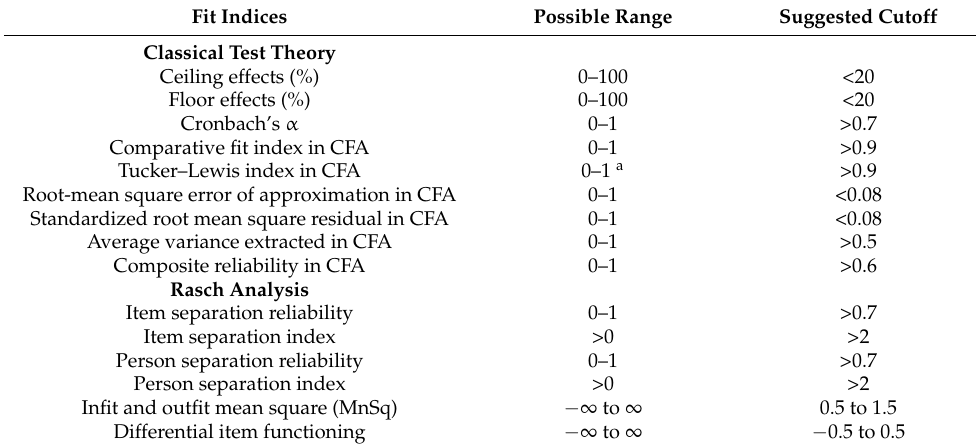
Table 1. Interpretations of the cutoffs used in the psychometric